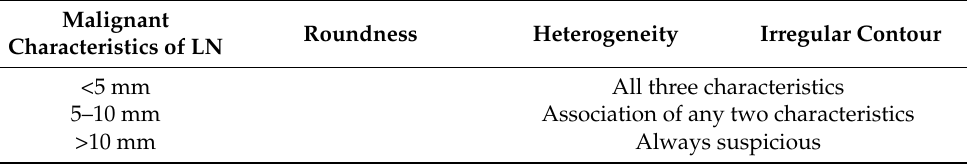
Figure 5. Case No. 6. Synchronous sigmoid and cecal tumors (white arrow), seen on contrast-enhanced CT scan, venous phase, axial views ( A , B ) and coronal view ( C ), with infiltration of pericolic fat, regional LNs (yellow circle) and left fallopian tube metastasis (white arrow-head). Map of nodal stations shows nodal stations with suspect LNs (rec circle) and nodal stations with visible LNs, without suspicious criteria ( D ). Table: correlation of suspect nodal stations with LN metastasis. Table 1. Suspicious LNs based on imaging malignant features (size and morphologic